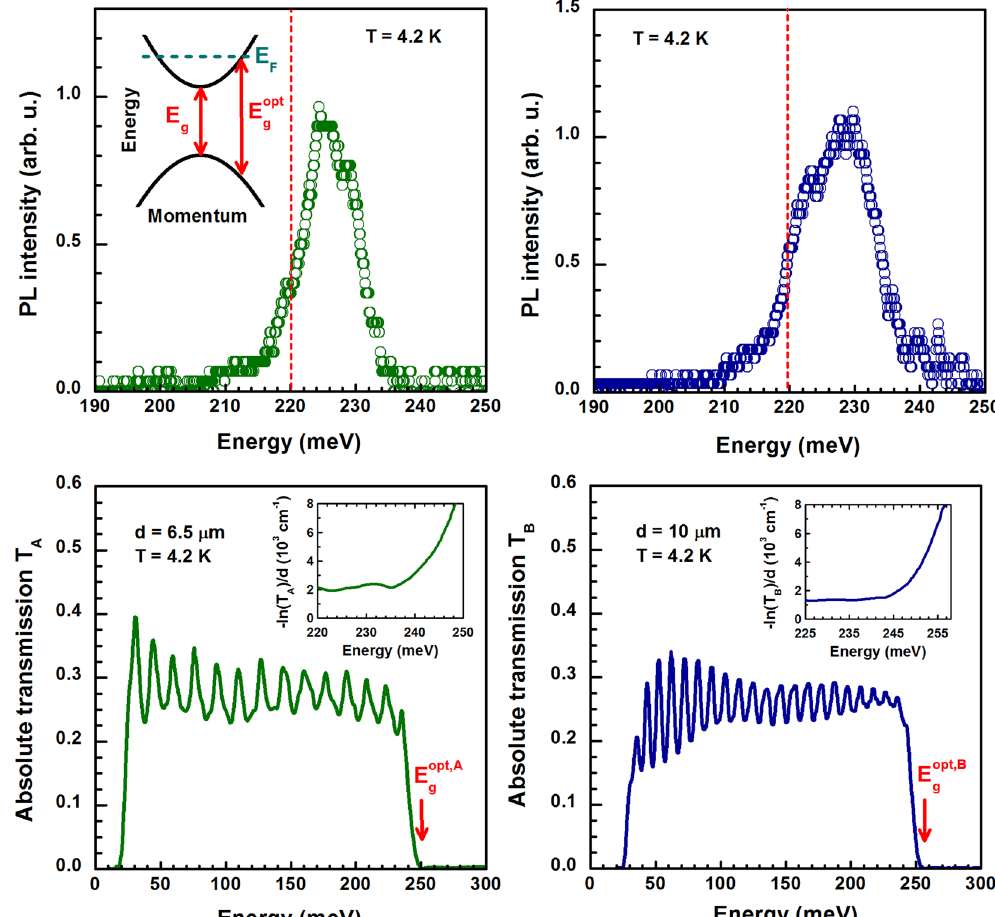
Figure 2. ( a , b ) Low-temperature PL spectra collected from samples A and B, respectively. The dashed vertical lines denote the estimated energy of the band gap, see the discussion in the main text. The schematic band structure of Bi 2 Se 3 is plotted in the inset of the part ( a ), the difference between E g and E Moss-Burstein shift. ( c , d ): Infrared transmission data T A and T B taken on samples A and B, respectively. The corresponding absorbance spectra, − ln( T )/ d , around the interband absorption edge E sample thickness, are plotted in the insets. The pronounced modulation of the transmission spectra is due to Fabry-Pérot oscillations, which show rather high crystalline quality of the studied Bi 2 Se 3 bulk samples and which allows us to estimate, knowing the thickness of the samples, the refraction index: n ≈